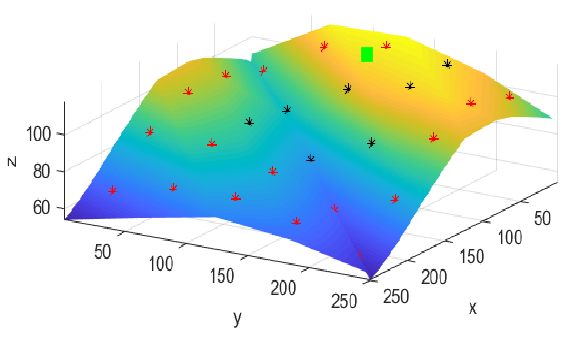
Figure 10. Communication status between nodes.